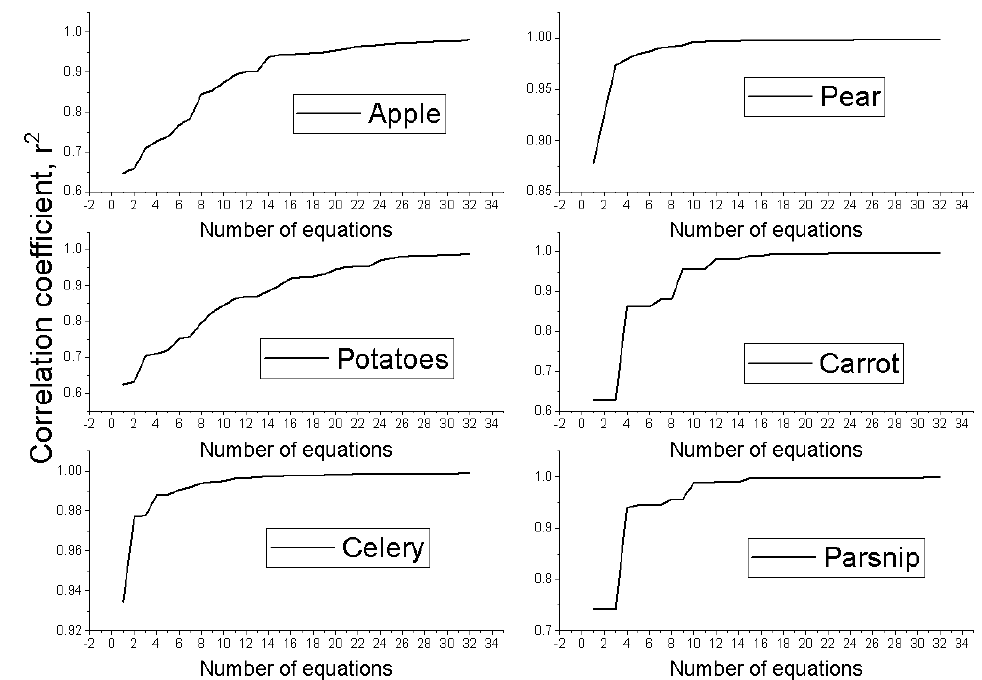
Figure 14. Variation of correlation coefficients for unpeeled products corresponding to common equations.